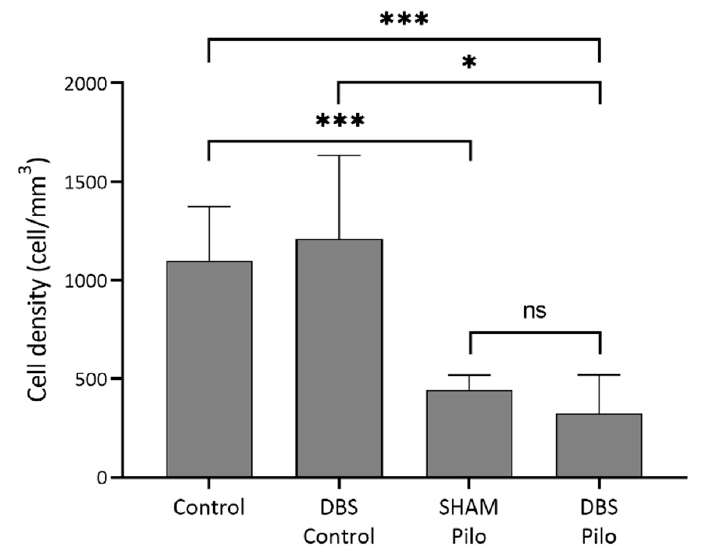
Figure 9. NPY+/nNOS+ cell density in the CA1 subregion of the hippocampus. There was a significant overall difference among groups (Welch’s ANOVA test). Multiple comparisons have shown that mean cell density was significantly lower in pilocarpine animals compared to controls. At the same time, there was no significant difference between the sham-operated group (SHAM-Pilo) and deep brain stimulation group (DBS-Pilo) groups. Data are presented as means ± SEM. * p < 0.05, *** p < 0.001, ns: no significant